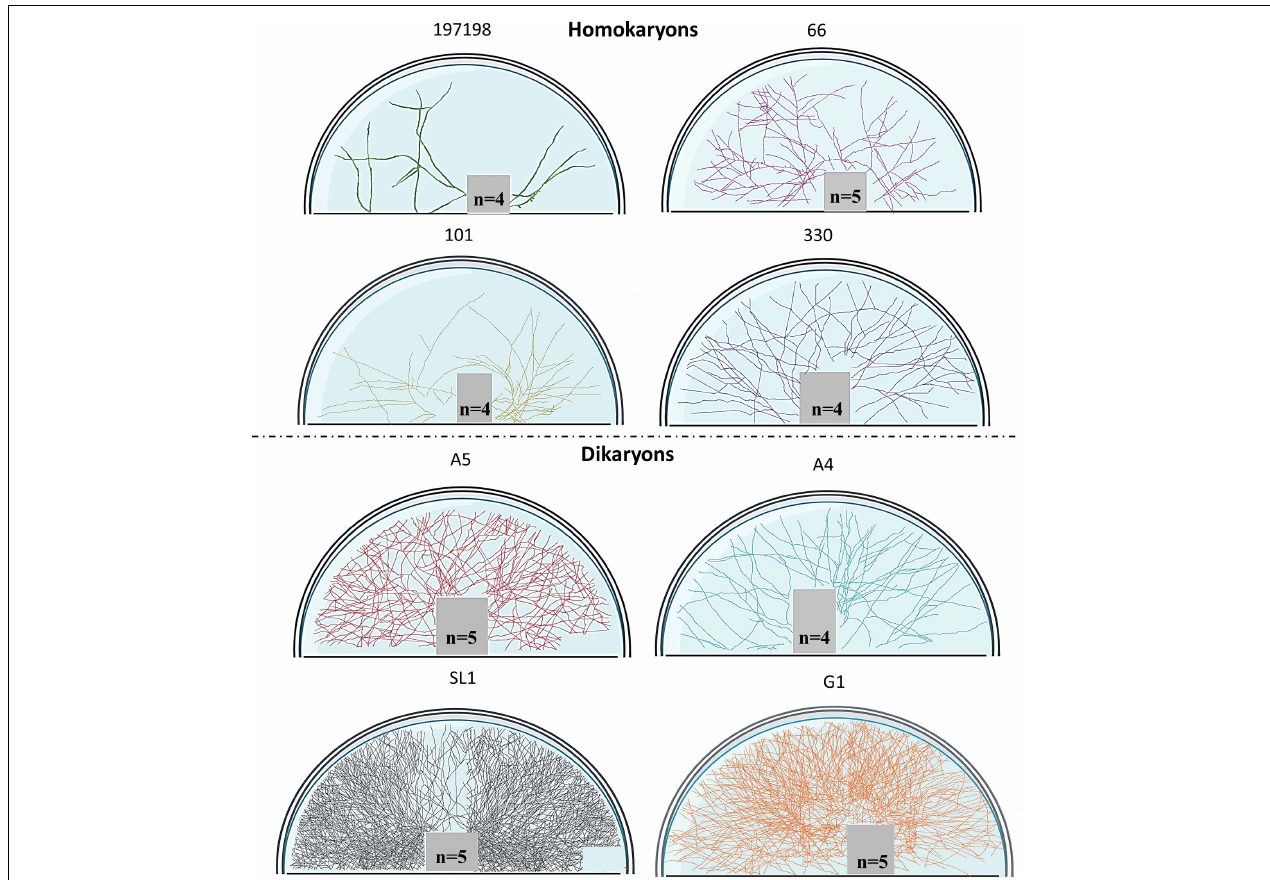
FIGURE 1 | Symbiotic hyphal growth of four homokaryotic and four dikaryotic strains in Cichorium intybus root organ cultures as a host. The images demonstrate the actual hyphal growth per strain 30 days after the hyphae crossed to the hyphal compartment of the Petri dish. The bridge and the lower right part of the Petri dish appear empty since hyphal growth could not be accessed as it was concealed by either the bridge or by the blurred part of the Petri dish (manufacturers feature). To correct for size variation of the filter bridge between plates, an area was removed from each image prior to determination of the hyphal traits. Although multiple plate replicates were analyzed per strain ( n number visible in each plate), we chose to demonstrate one representative plate per strain.